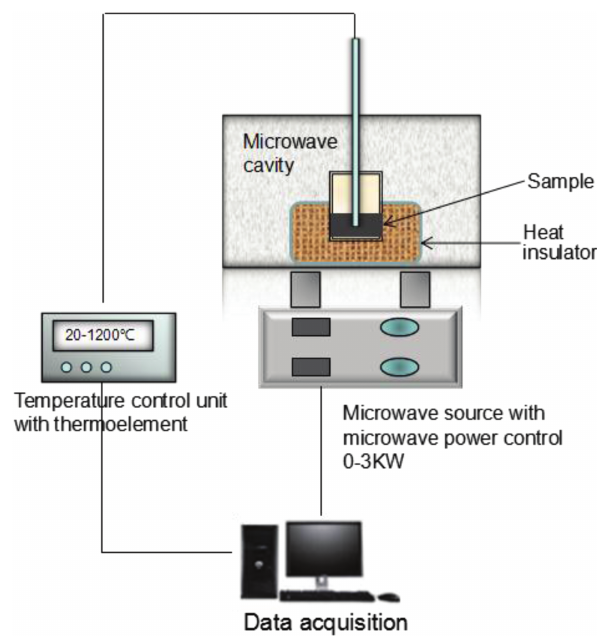
Figure 3: Schematic of the microwave oven used in this